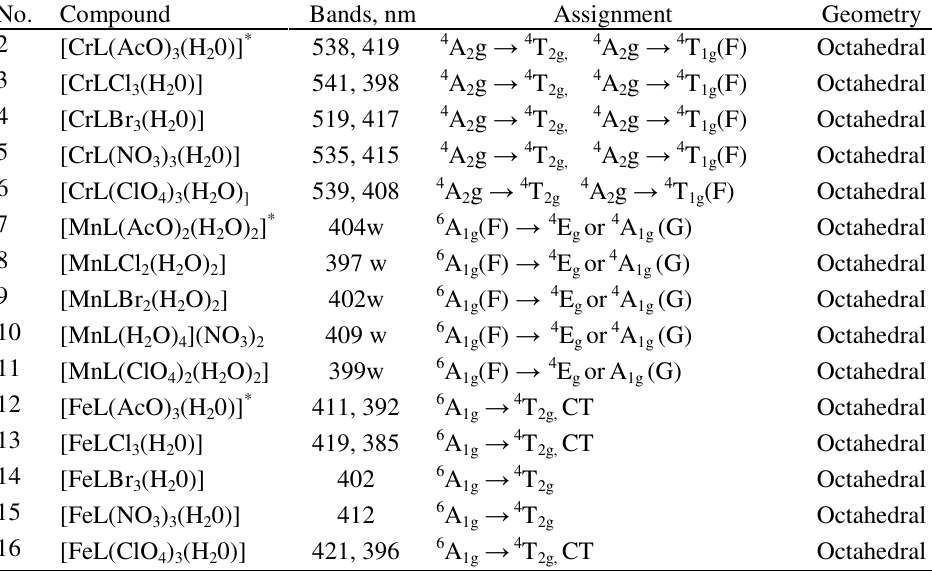
Table 3. Electronic spectral bands of Cr(III), Mn(II) and Fe(III) complexes and their